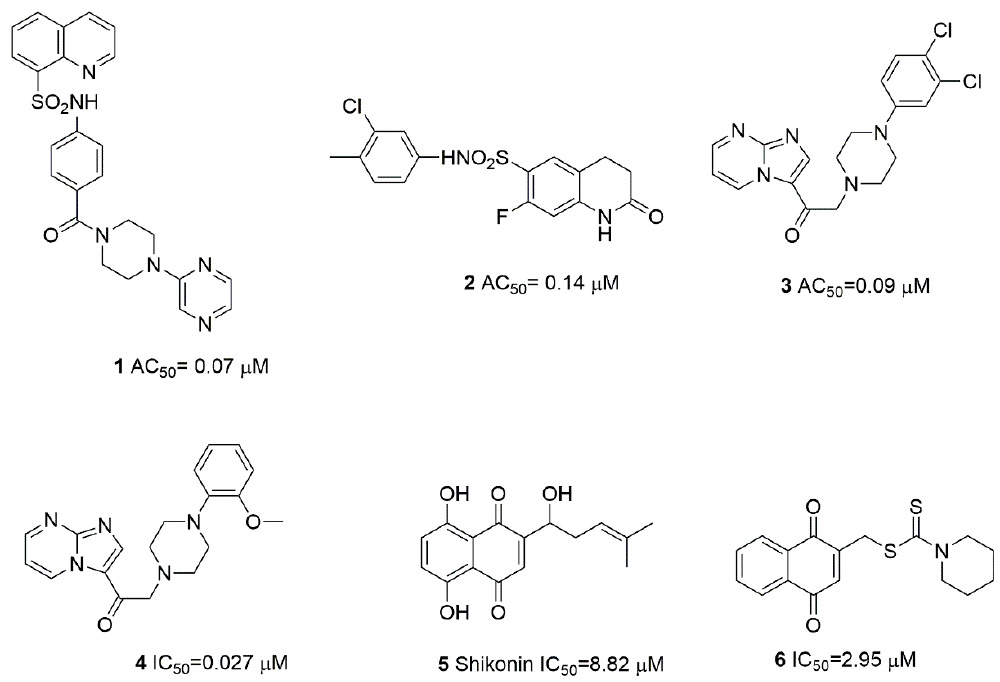
Figure 1. Reported pyruvate kinase M2 modulators ( 1 – 3 activators, 4 – 6 inhibitors) [17–19].